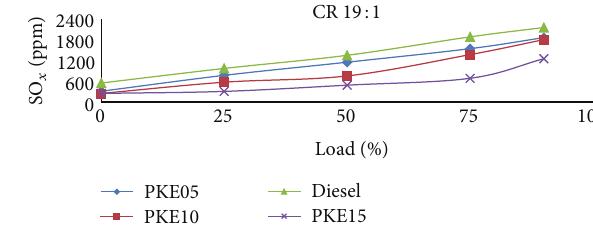
Figure 19: Load versus SO 𝑥 emissions at 14:1 CR.